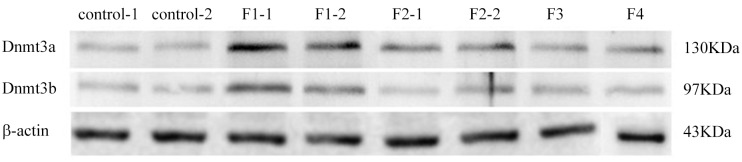
Control group and DEHP experimental group offspring (F1-F4) male rat’s DNMT3a expression.Result shows that with the increase of genetic algebra, the expression level of DNA methyltransferase gradually lowered, the testicular damage degree is reduced.